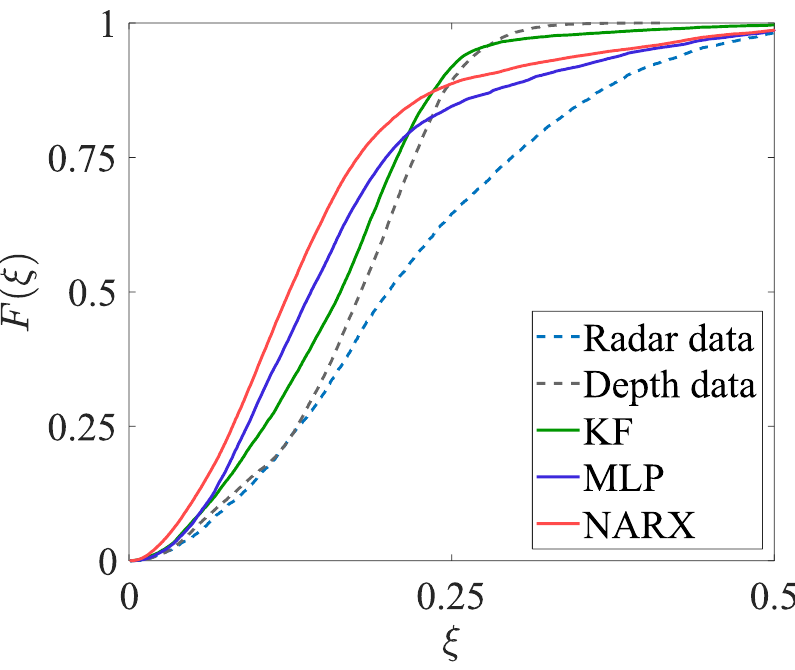
Figure 6. Zoom on the empirical cumulative distribution functions characterising the position errors, obtained in EXP#1. Table 1. Values of the uncertainty indicators, calculated on the basis of the position errors, obtained in EXP#1.